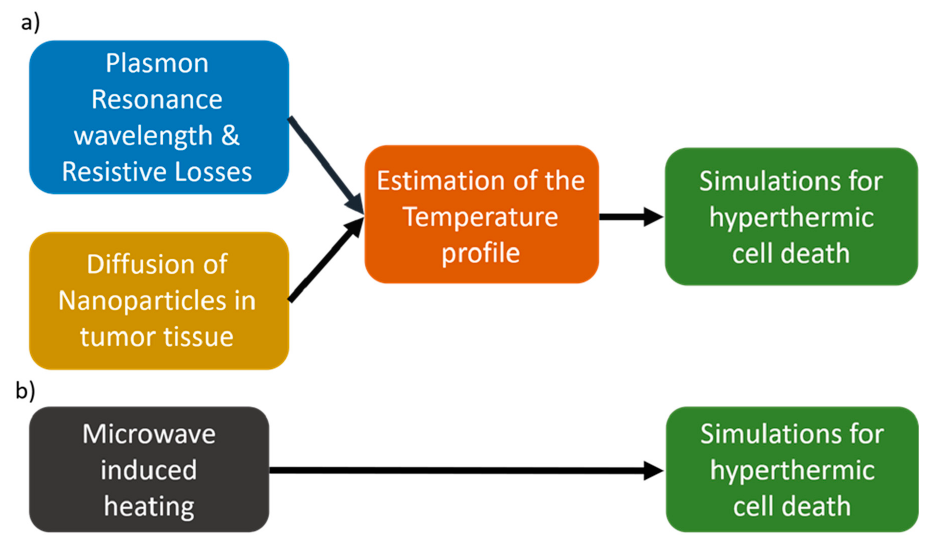
Figure 6. Workflow for the estimation of tumor shrinkage using ( a ) gold nanoparticle-induced hyperthermia and ( b ) using microwave-induced hyperthermia.